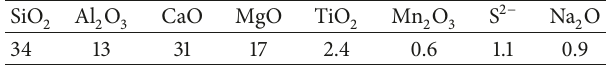
Table 3: Chemical composition of GGBFS